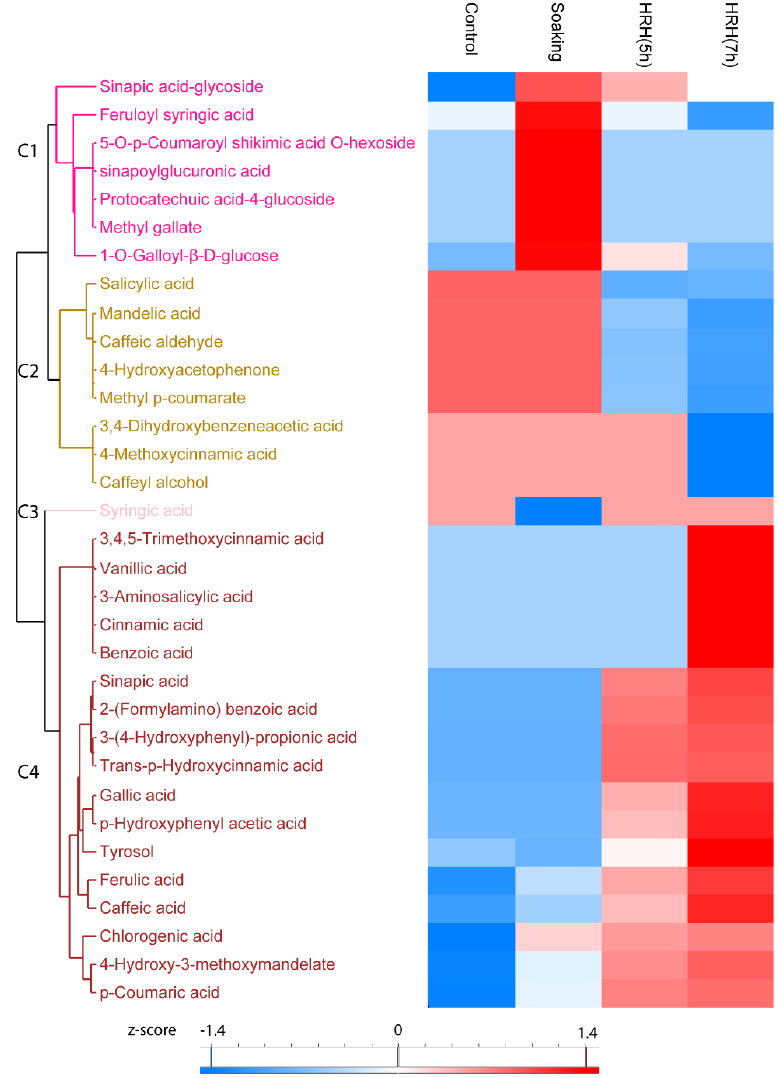
Figure 4. Hierarchical cluster analysis based on peak area of phenolic acids. C1 – C4: Cluster 1 – 4.